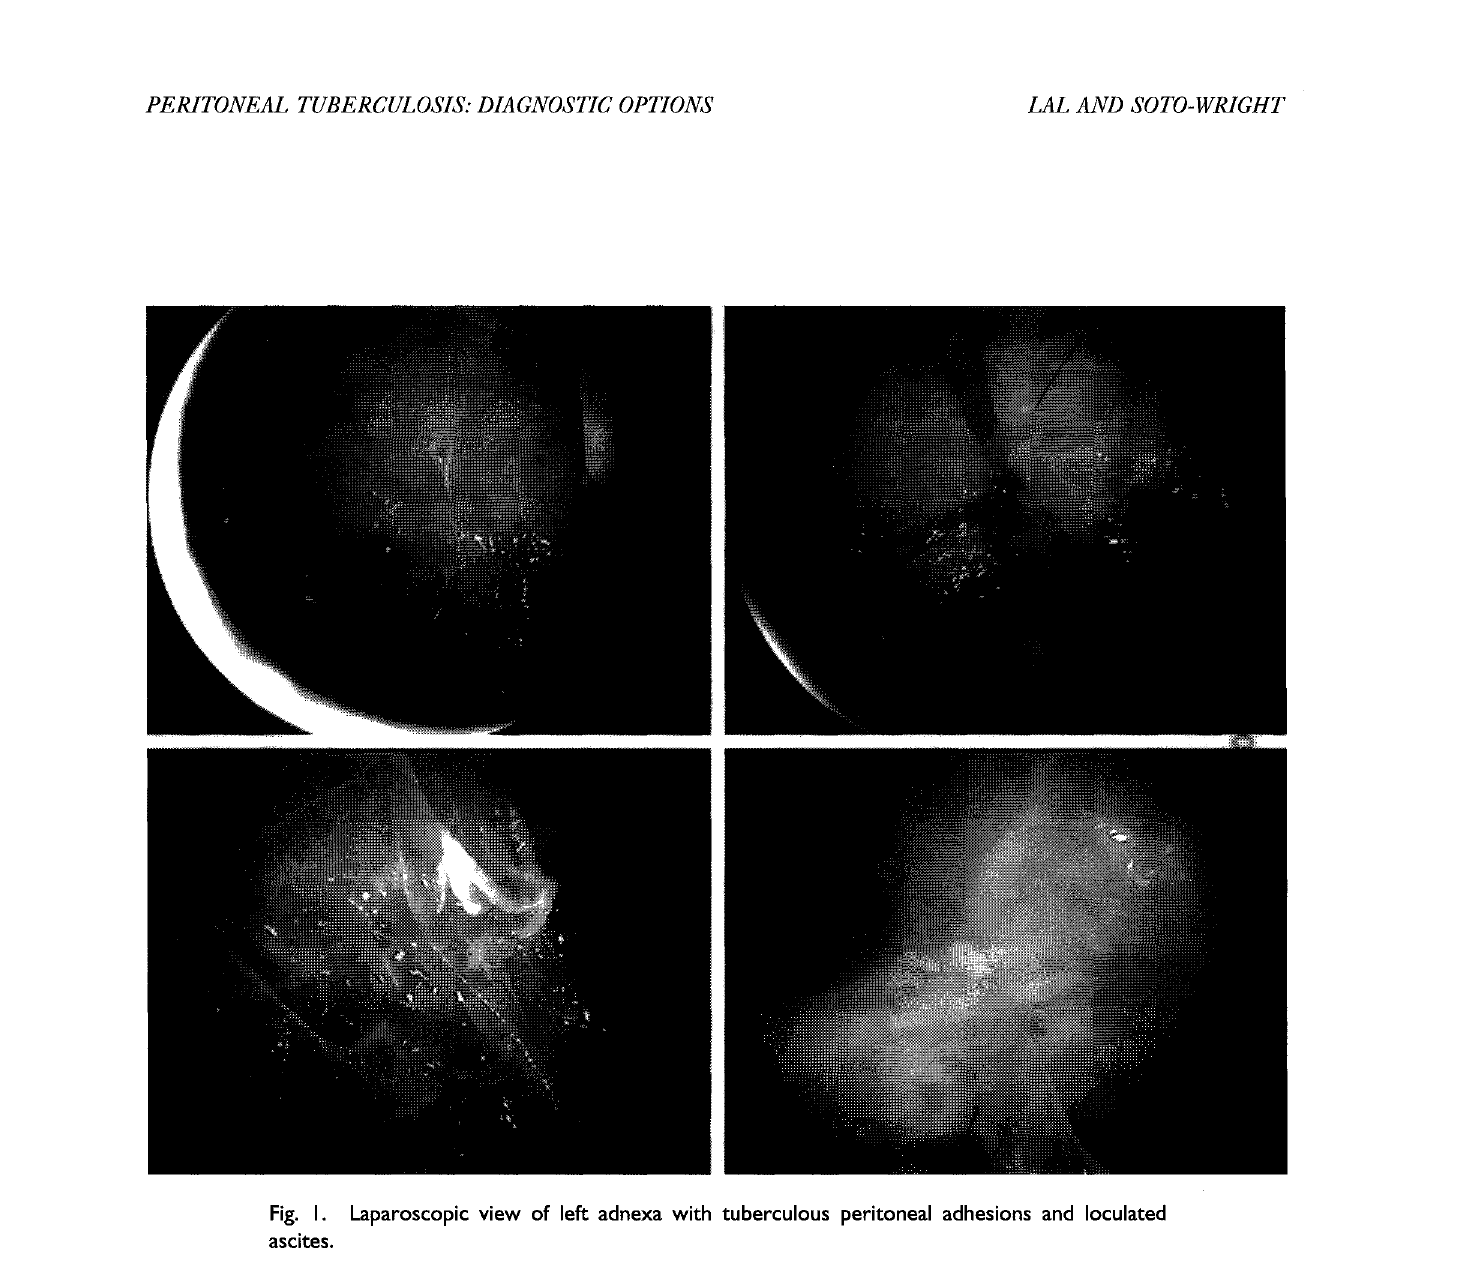
Fig. I. Laparoscopic view of left adnexa with tuberculous peritoneal adhesions and Ioculated